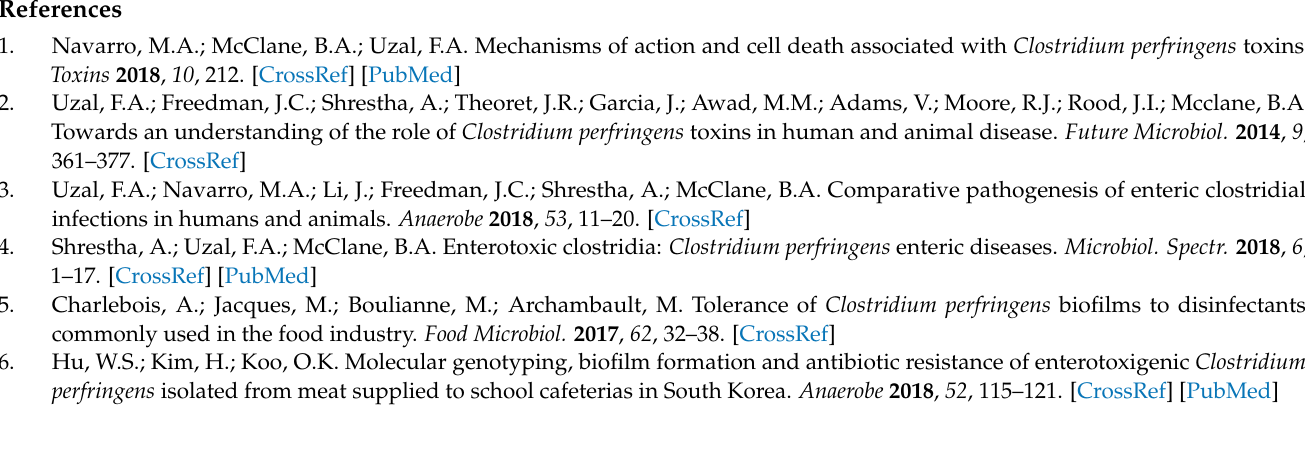
Supplementary Materials: The Supplementary table is available online at https://www.mdpi.com/ Table S2. Primers used in this study. Figure S1. Agarose gel electrophoresis of the total RNA